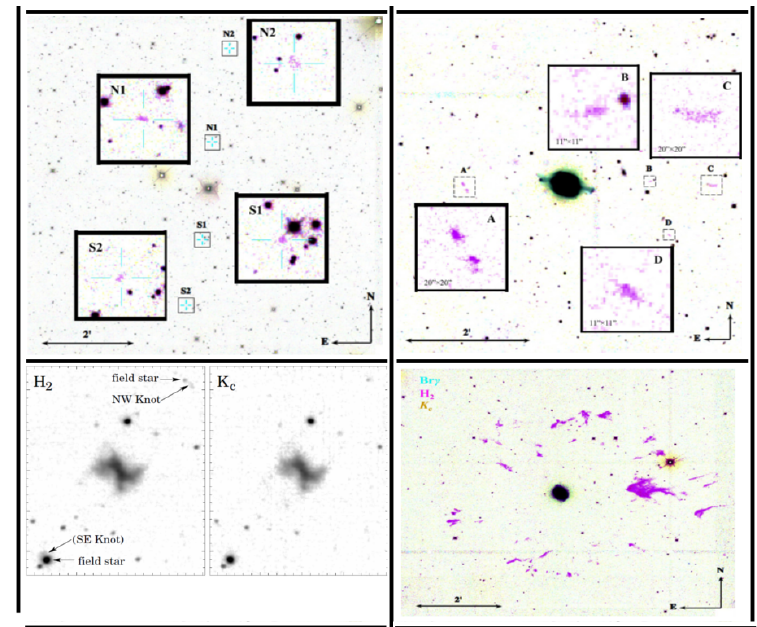
Figure 1. H 2 images of Hb 12 (top-left panel, [14]), NGC 7009 (top-right panel, [15]), Hu 1-2 (bottom-left panel, [15]) and NGC 6543 (bottom-right panel, [15]). The insets on the top panels show a zoom in the H 2